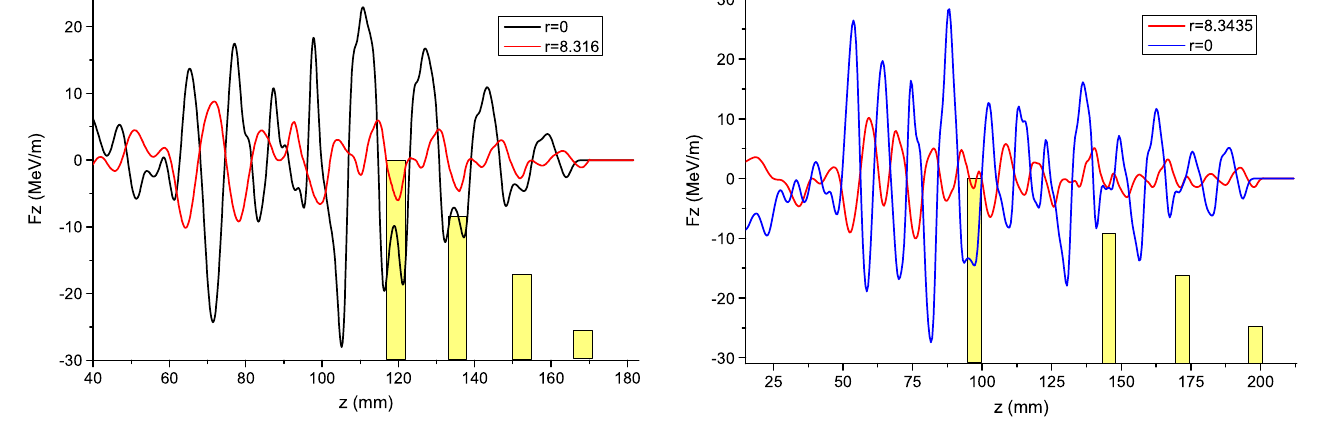
FIG. 5. Axial wakefields excited by a ramped bunch charge of drive bunches spaced by 1.5 wakefield